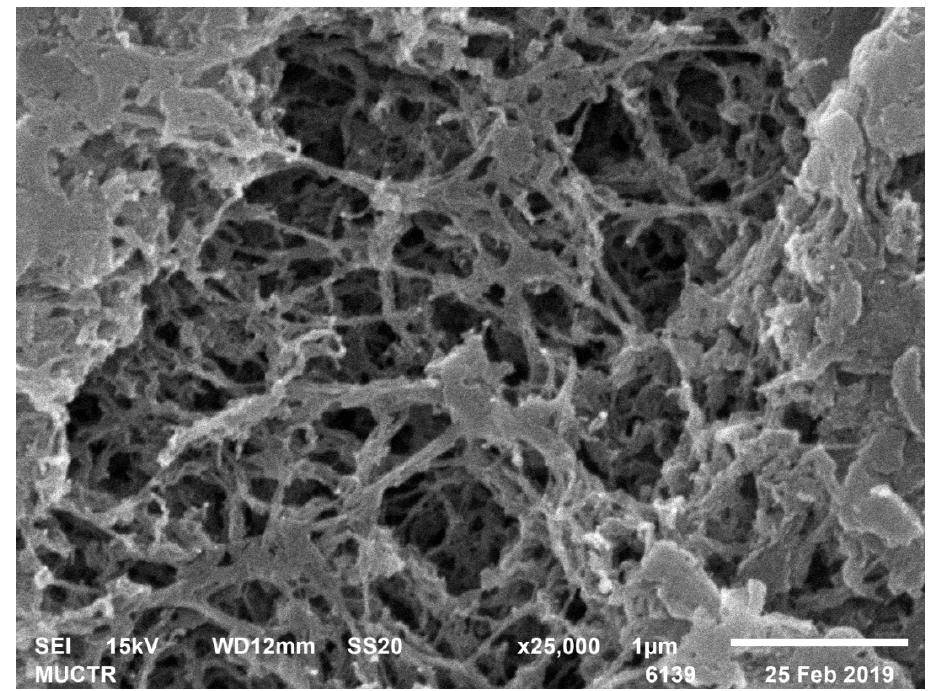
Figure 5. SEM-image of sample 3 chitosan-based aerogel particles.